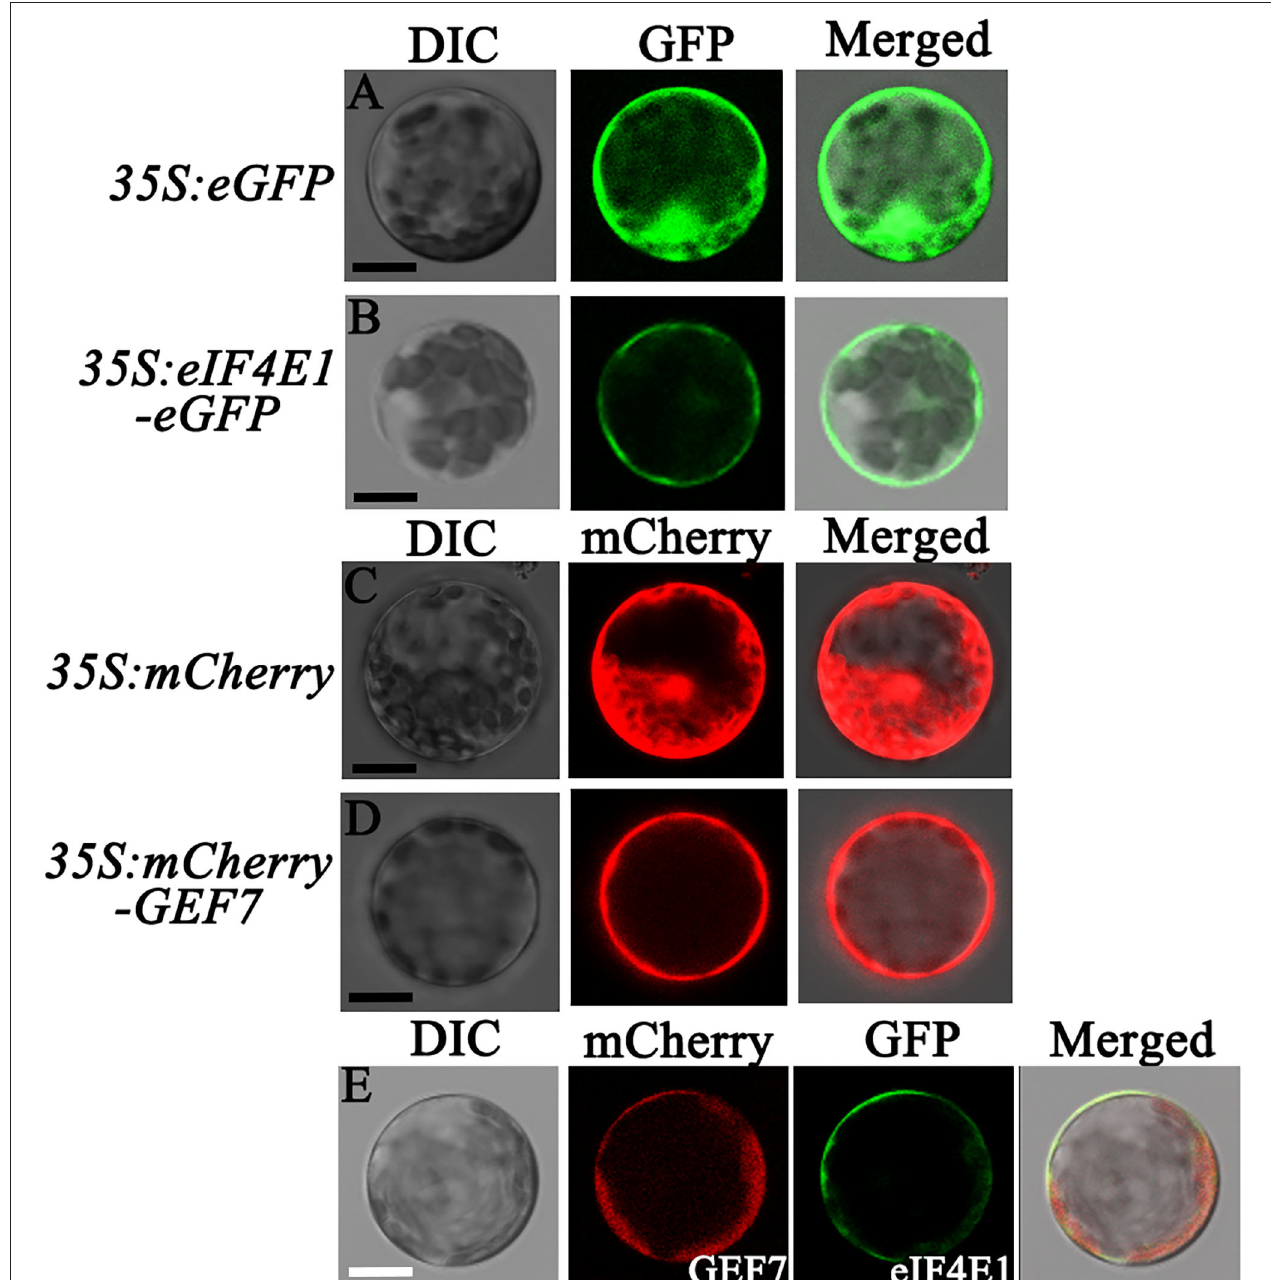
FIGURE 8 | Subcellular localization of eIF4E1 and RopGEF7 in Arabidopsis protoplasts. (A-D) Subcellular localization of GFP from a cell harboring a 35S:eGFP empty vector (A) , GFP-tagged eIF4E1 in a 35S:eIF4E1-eGFP expressed cell (B) , mCherry in a cell expressed 35S:mCherry empty vector (C) , and mCherry-labeled RopGEF7 in a 35S:mCherry-RopGEF7 expressed cell (D) in Arabidopsis protoplasts, respectively. (E) Co-localization of eIF4E1-eGFP and mCherry-RopGEF7 in Arabidopsis protoplasts. Scale bars: 20 µ